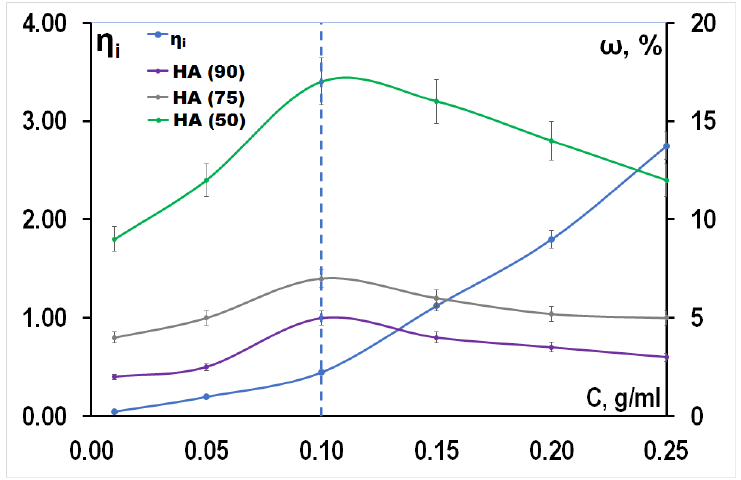
Figure 5. The dependence of the amount of PLGA, localized in the materials and the inherent viscosity by concentration of the solution.